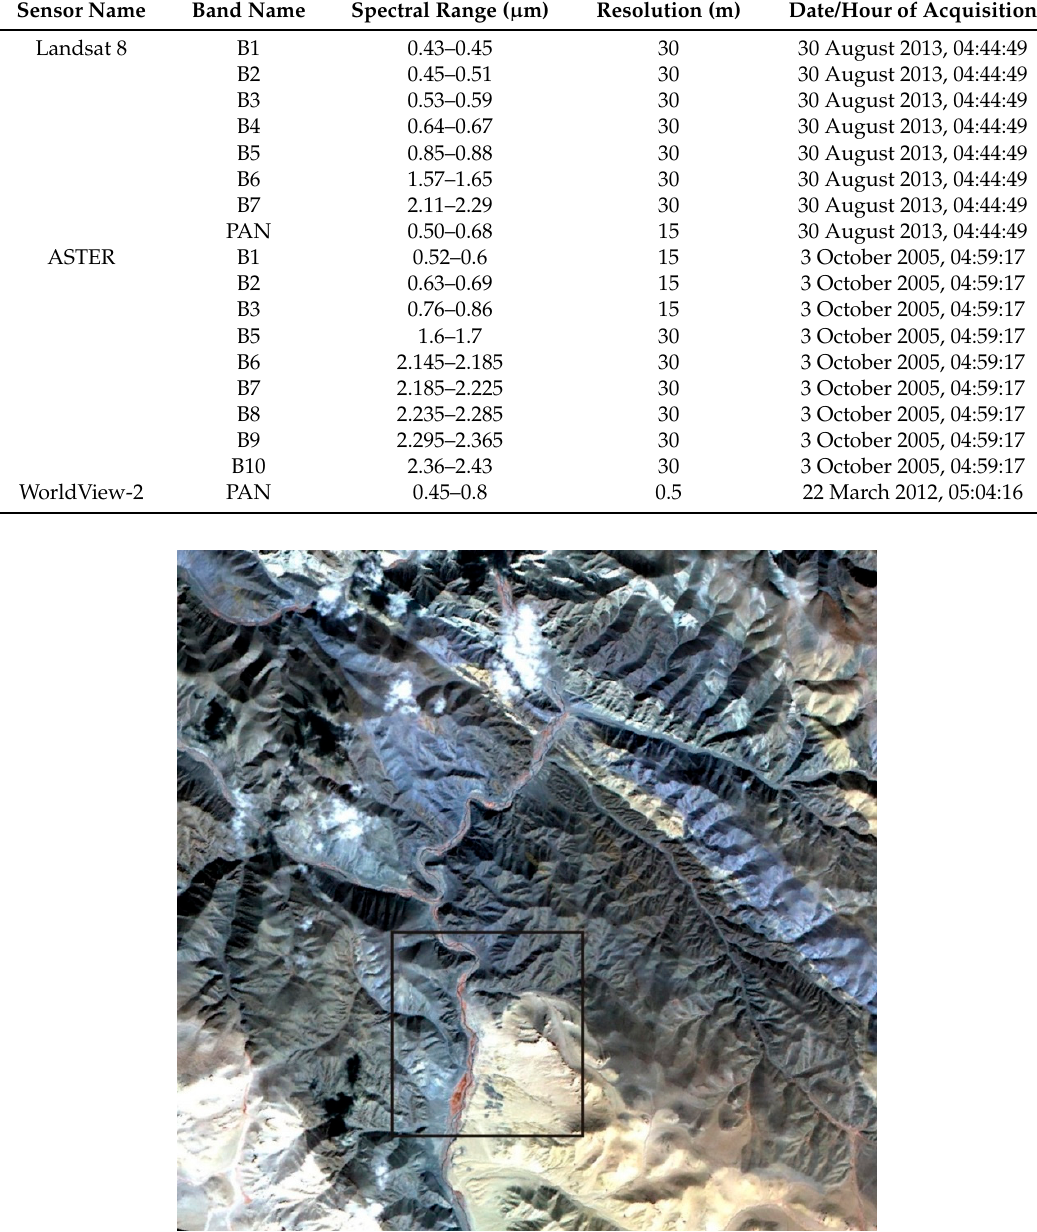
Figure 2. Sharpening study area (ASTER image data, RGB bands B3, B2, B1).